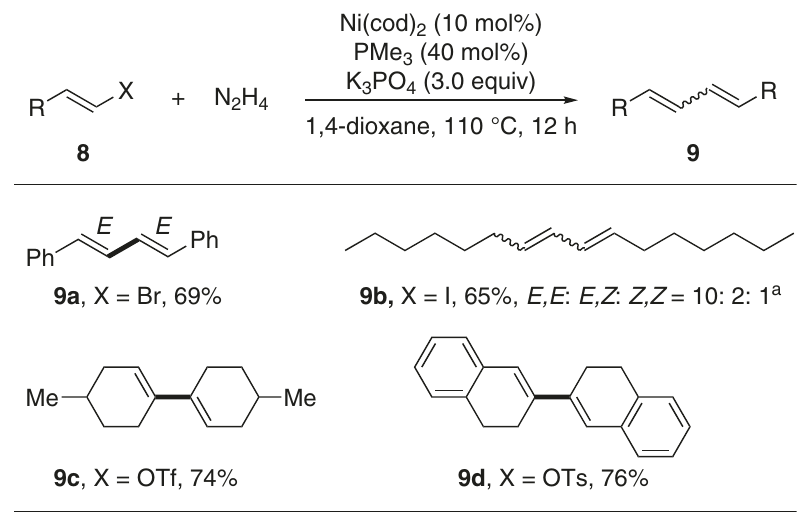
Fig. 5 Homo-coupling of vinyl electrophiles to build conjugated dienes. Reaction conditions: 8 (0.2 mmol), N 2 H 4 (0.1 mmol), Ni(cod) 2 (10 mol%), PMe 3 (40 mol%), K 3 PO 4 (0.6 mmol), 1,4-dioxane (1.0 mL), 110 °C, 12 h under N 2 . Reported yields are the isolated ones. a The E/Z ratio was determined by GC